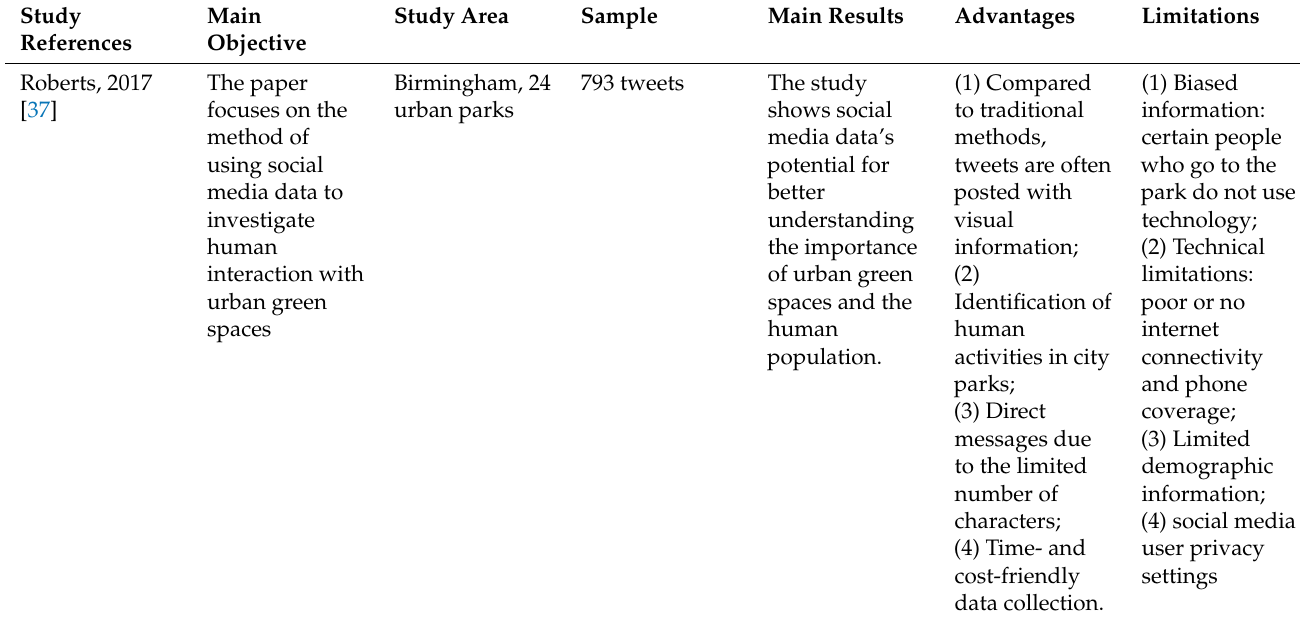
Figure 3. Spatial representation of countries in which social media platforms were used in the 22 studies. Base map credits National Geographic Society.